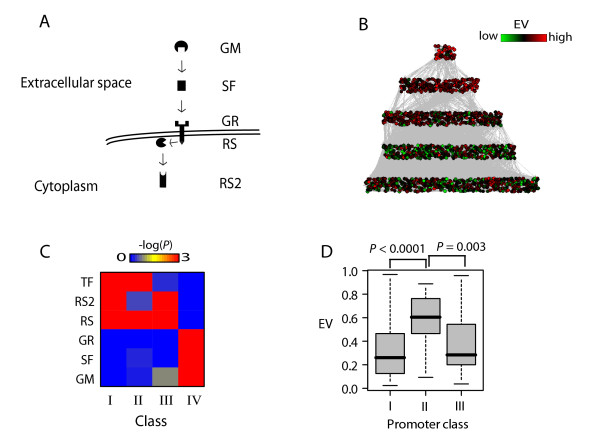
Pattern of EV along the signaling hierarchy. A) A visual depiction of the signaling hierarchy as defined in text and Methods. B) Network plots of the signaling hierarchy. Each layer corresponds to the corresponding layer in A. Node colors show EVexpo values of corresponding genes and lines indicate directed protein-protein interactions. C) Heatmap of enrichment p-values of each gene class as defined in Kim et al (2005) for genes in corresponding signaling hierarchy levels. Colors indicate negative log (base 10) of p-values as determined by hypergeometric distribution formula. D) Boxplots of EV values of RS level genes with class I, II and III promoters. P-values of difference were calculated by Wilcoxon rank sum test.